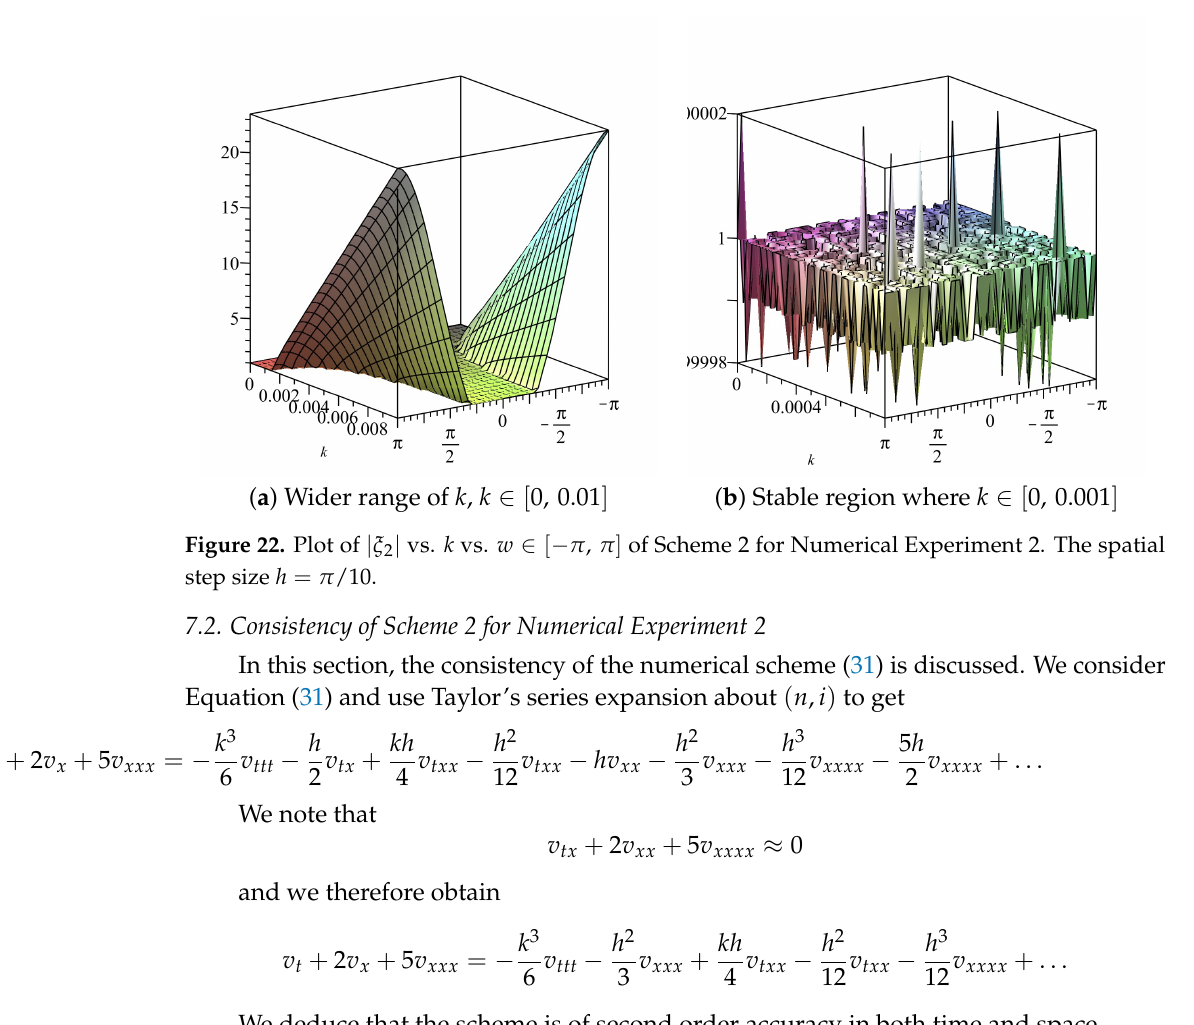
Figure 21. Plot of | ξ 1 | vs. k vs. w ∈ [ − π , π ] of Scheme 2 for Numerical Experiment 2. The spatial step size h = π /10.